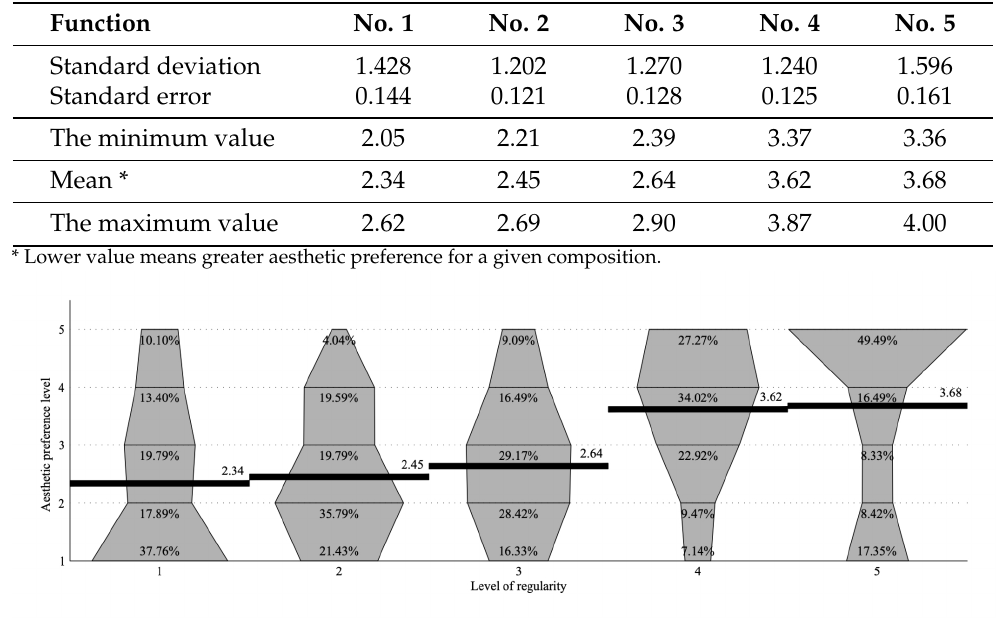
Figure 7. Distribution of aesthetic preferences in relation to the degree of regularity of the facade.